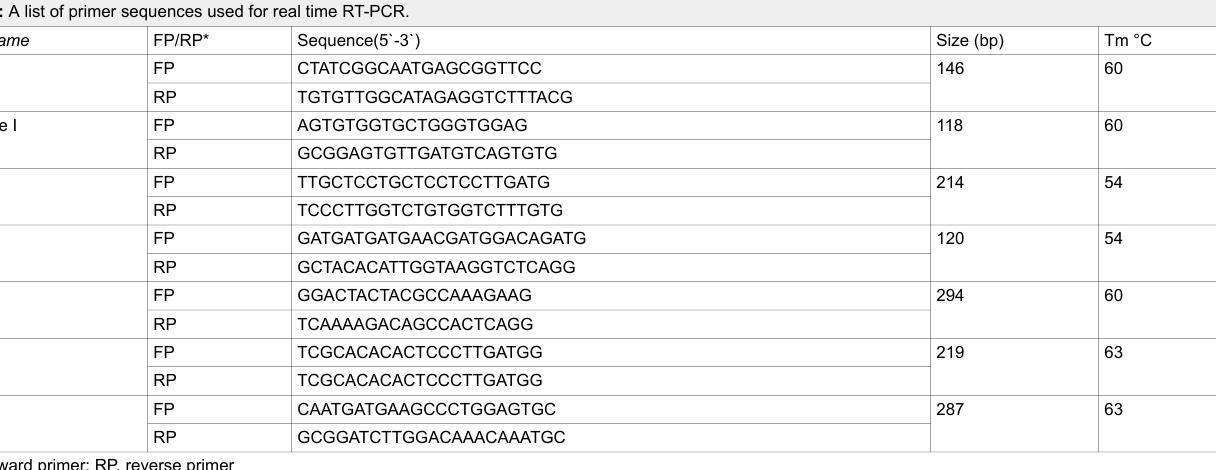
*FP, forward primer; RP, reverse